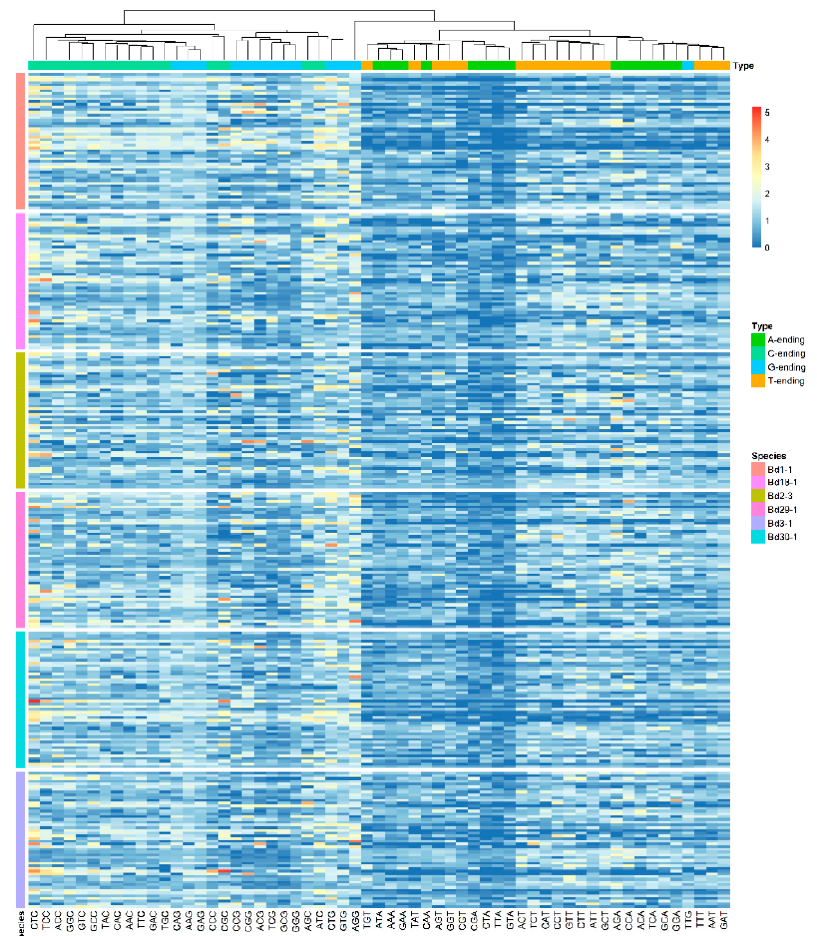
Figure 5. The relative synonymous codon usage (RSCU) values of the six genomes. A total of 50 genes were selected randomly from each of the six lines; these were plotted according to the RSCU values of 59 codons (Met, Trp and the three stop codons were omitted). The genes are represented in rows and the codons are represented in columns.